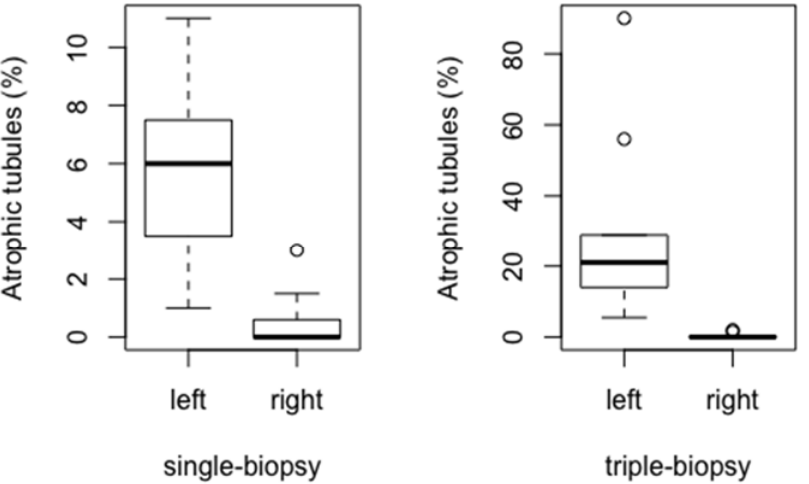
Figure 9. Comparison of the ( A )—volume and ( B )—apoptotic index of the left (punctured) and right (intact) testicles in triple biopsy group (Student t -test, p < 0.01). Higher percentage of atrophic tubules has been found in the group of left (biopted) testicles compared to the right (intact) testicles in single-biopsy ( p < 0.001) and triple-biopsy ( p < 0.001) groups (Figure 10).